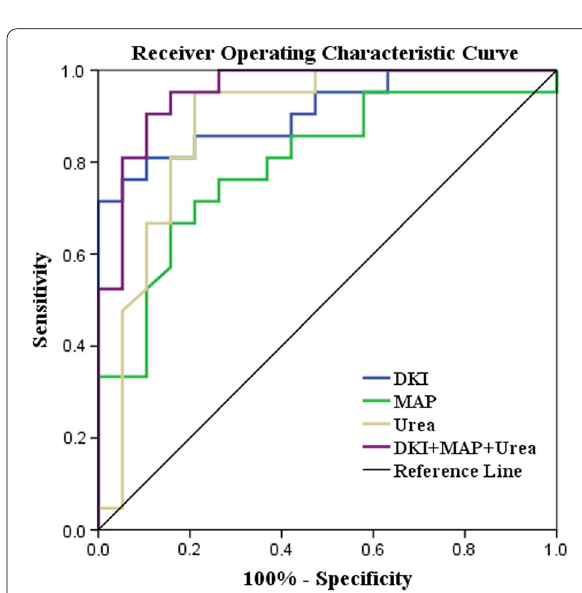
Fig. 7 Receiver operating characteristic (ROC) curves of DKI and clinical indicators in discriminating stable renal function from impaired renal function. Combining DKI with MAP and urea can improve the diagnostic performance (AUC, 0.